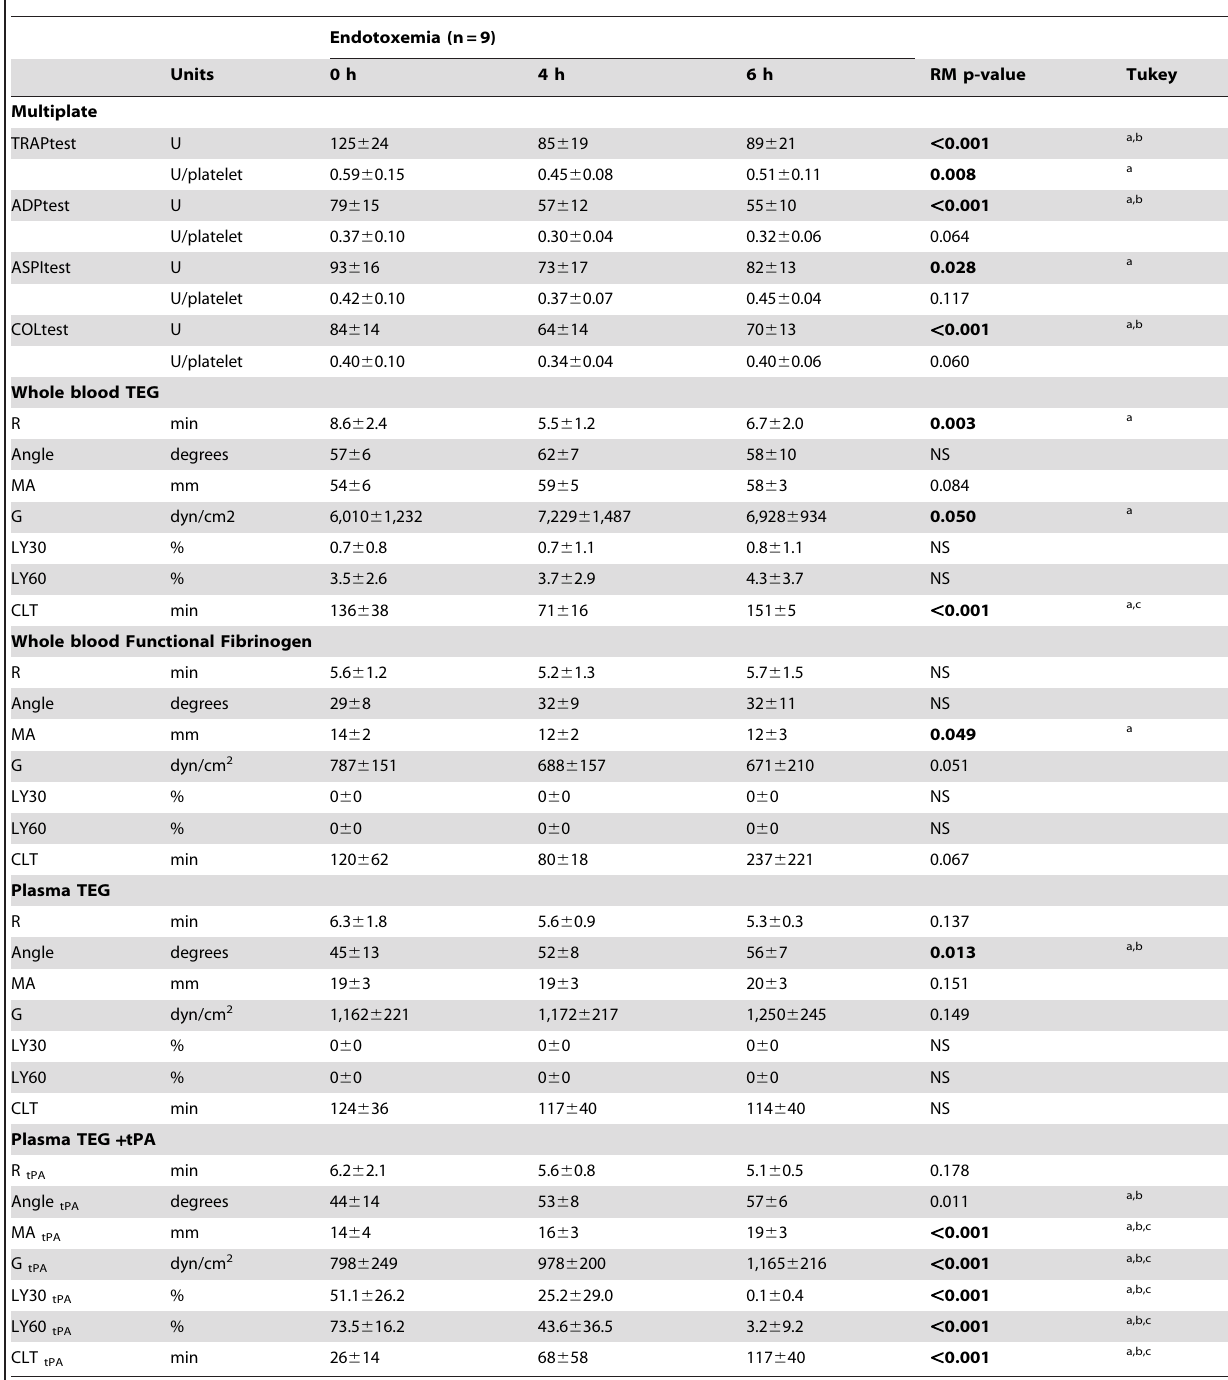
Table 2. Functional hemostatic assays in whole-blood (impedance aggregometry (Multiplate), Thrombelastography (TEG), Functional fibrinogen) and plasma (TEG with or without addition of tPA to induce fibrinolysis) in nine healthy volunteers before, during and after induction of experimental endotoxemia by means of a 4 h LPS-infusion (0.5